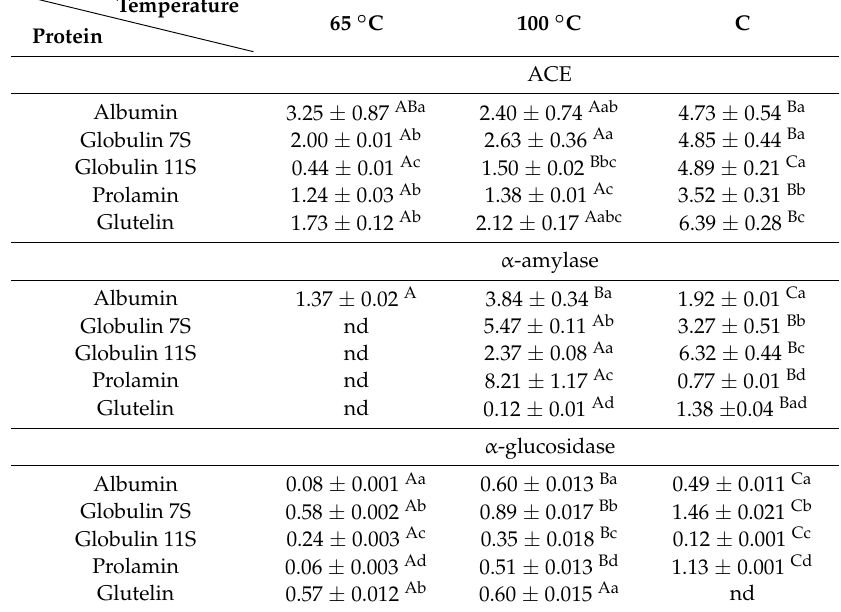
Table 2. The IC 50 values (mg/mL) of hydrolyzates for inhibitory activity of enzymes involved in metabolic syndrome